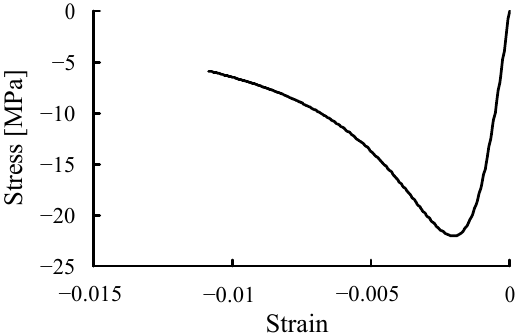
Figure 3. Compressive stress–compressive strain curve for concrete filling.